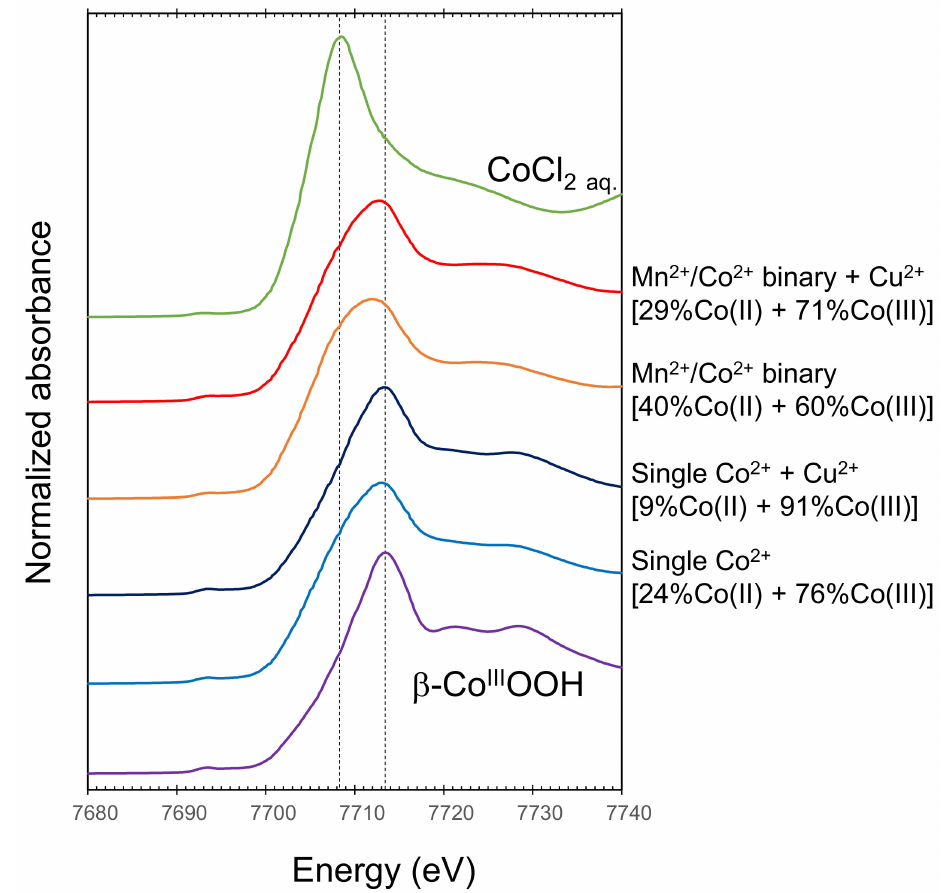
Figure 7. Co K-edge X-ray absorption near-edge structure (XANES) spectra of newly formed biogenic manganese oxides (BMOs; 1 mM as Mn) repeatedly treated in Co 2+ /Mn 2+ binary and single Co 2+ solutions under aerobic conditions at pH 7.0 (100 mM HEPES buffer). Concentrations of Co 2+ and Mn 2+ were 0.8 mM. Newly formed BMOs were subsequently treated with 10 mM CuSO 4 (Cu 2+ - extraction) for 24 h to remove exchangeable Co 2+ . XANES spectra of aqueous CoCl 2 solution and chemically synthesized Co III OOH were measured as reference materials for Co(II) and Co(III), respectively, and used as a linear fitting combination to estimate Co(II) and Co(III) contents in BMO